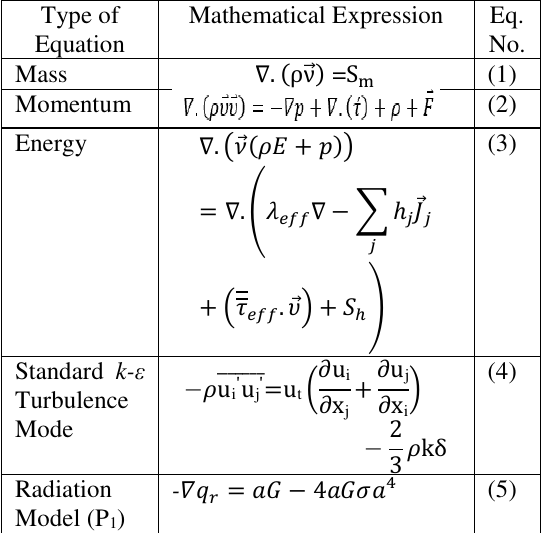
Table 2: Few pre-selected governing equations for the CFD analysis Type